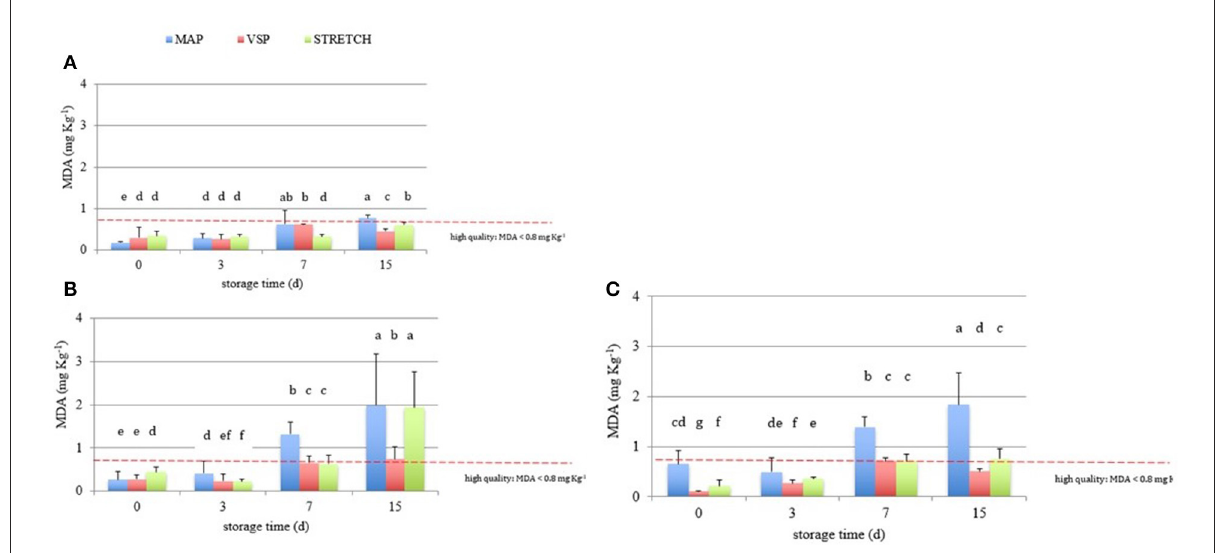
FIGURE4 Behavior of TBARS values (MDA, mg kg − 1 ) in breast (A) , in drumstick (B) and in leg (C) of chicken meat; data were observed during the refrigerated storage time (0, 3, 7, and 15 days, at 4 ◦ C) of samples packaged in modified atmosphere (MAP), in air (STRETCH), and under vacuum (VSP). In each graph, data signed with different letters are significantly different (LSD test, p < 0.05).